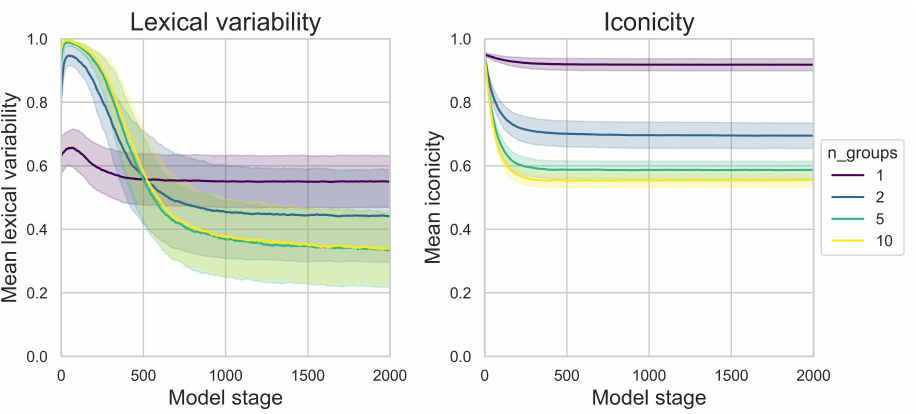
Figure 10. The mean lexical variability over the 2000 model stages for 100 repetitions of a run with 10 agents being assigned to different groups depending on the run. The dark line represents the mean and the shaded area represents the standard deviation of the 100 repetitions. It is evident that there is a relationship between the number of groups and the speed of the decrease of lexical variability, as well as the final amount of lexical variability in the population: The more groups in the population, the higher the initial lexical variability (at stage 0) but the lower the final lexical variability (at stage 2000). In addition, when there are fewer groups, the degree of iconicity is